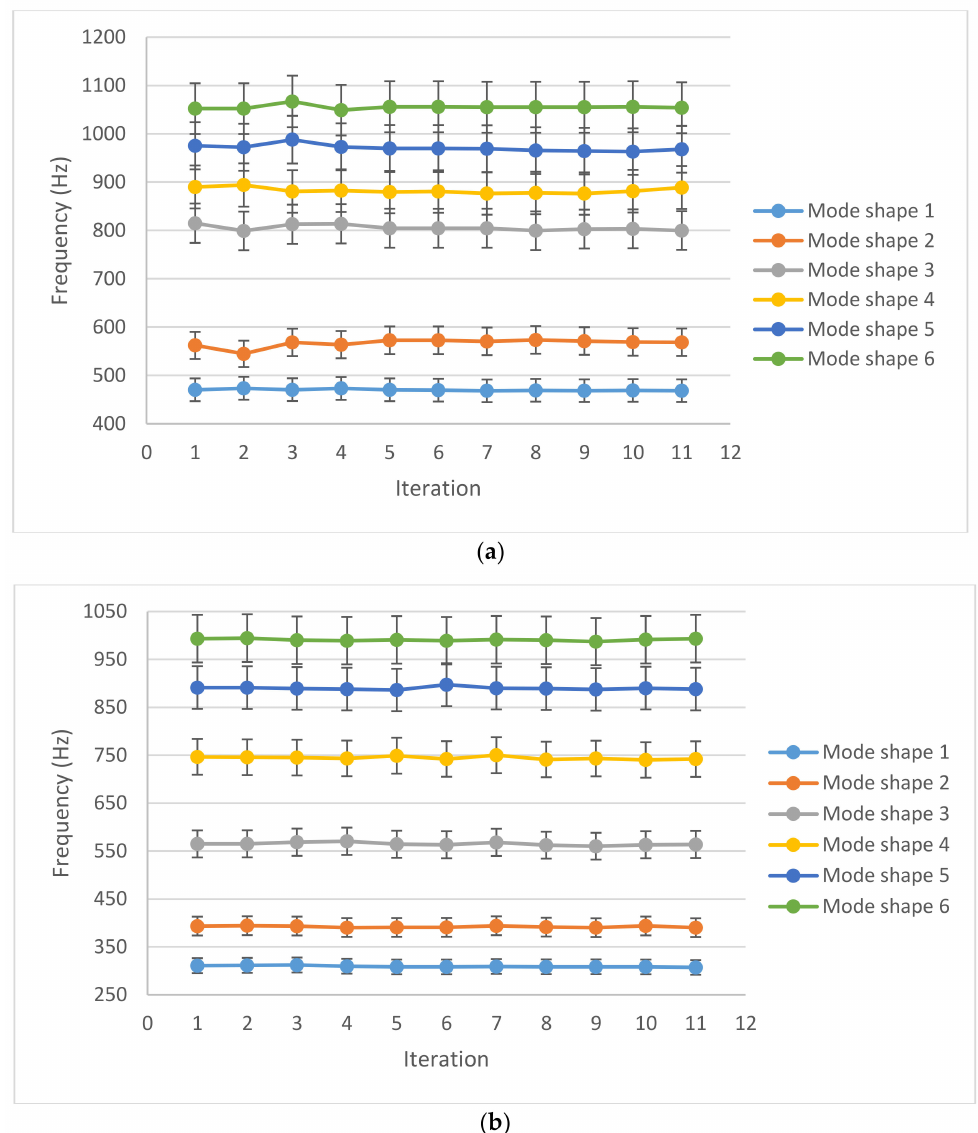
Figure 9. Mode shapes frequency for 11 repetitions; ( a ) boundary condition 1, ( b ) boundary condi- tion